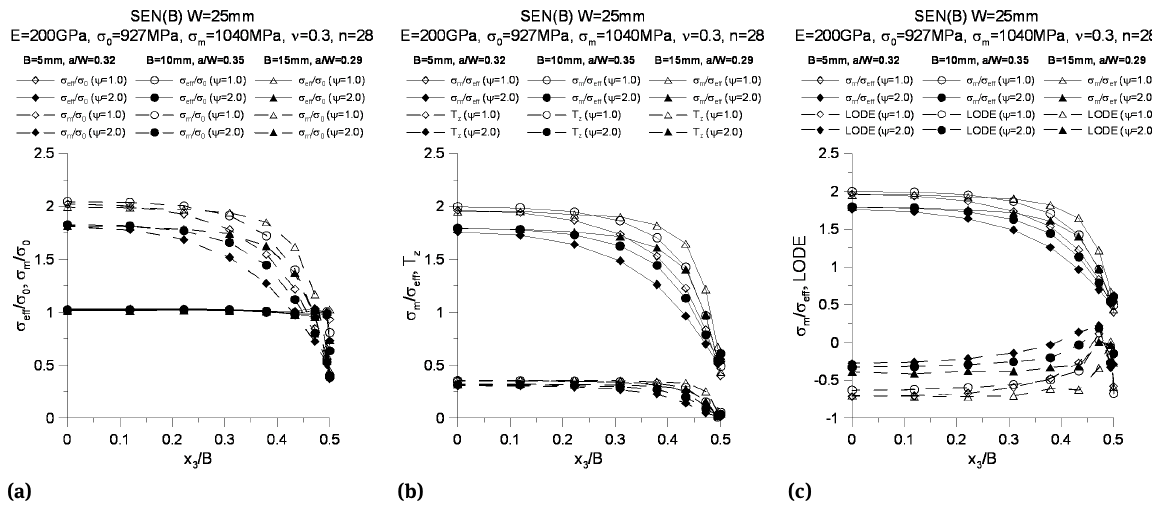
Figure 10: Comparison of: a) the effective stress ( σ eff / σ 0 ) and mean stress ( σ m / σ 0 ); along the crack front; b) stress triaxiality parameter ( σ m / σ eff ) and Guo Wanlin stress triaxility parameter ( T z ) ; c) stress triaxiality parameter ( σ m / σ eff ) and LODE parameter ( LODE ); for two selected distances from the crack tip ( r = 1.0 · J / σ 0 and ( r = 2.0 · J / σ 0 ) for three SEN(B) specimens made of 145Cr6 steel ( x 3 / B = 0.500 –